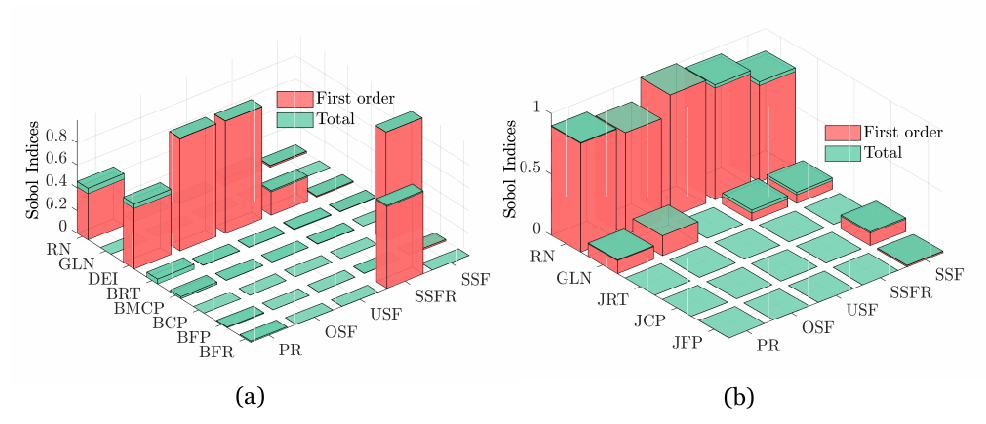
Figure 12. Sobol indices: ( a ) Base and ( b )